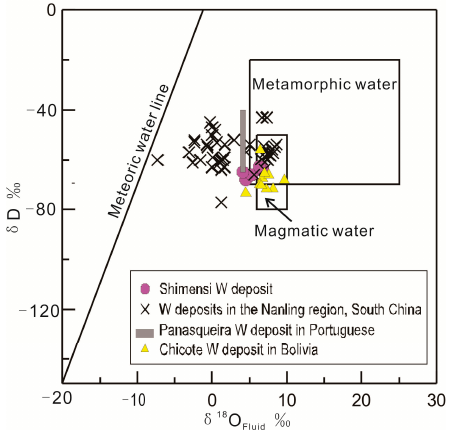
Figure 5. δ 18 O vs. δ D diagram of the Shimensi ore-forming fluids. Base map from Taylor [46].